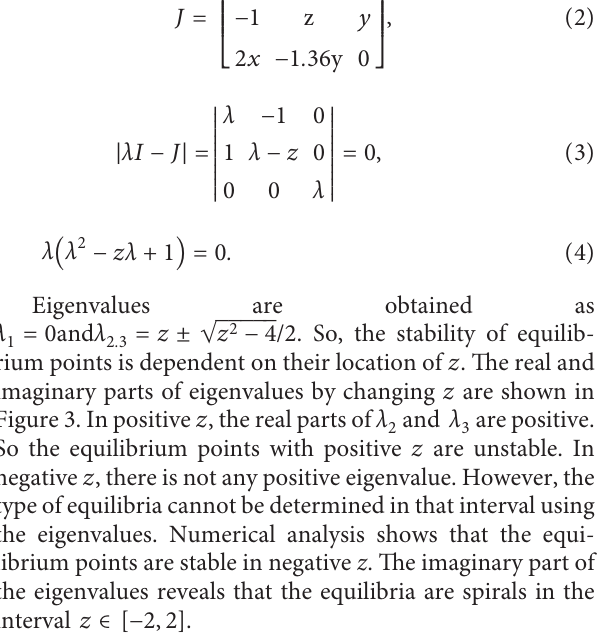
and λ are positive. 2 3